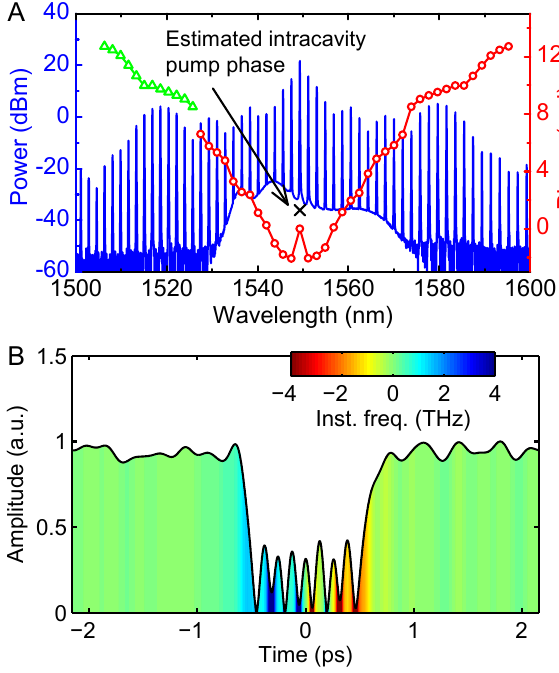
Figure 17: Complex chirp structure of dark pulses. (A) Comb spec- trum and phase. The phase profile marked in red is retrieved through line-by-line shaping. The green part is out of the pulse shaper’s passband and is estimated based on spectral